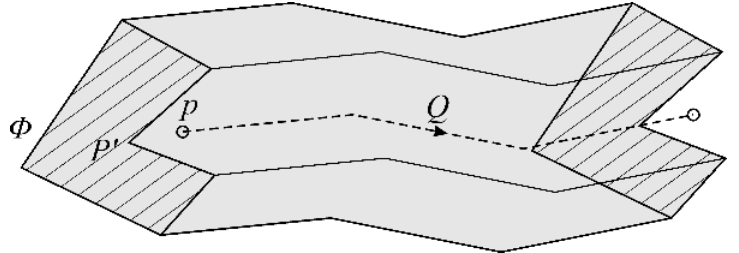
Figure 3. Region of movability for polygon P with line Q as the background feature.